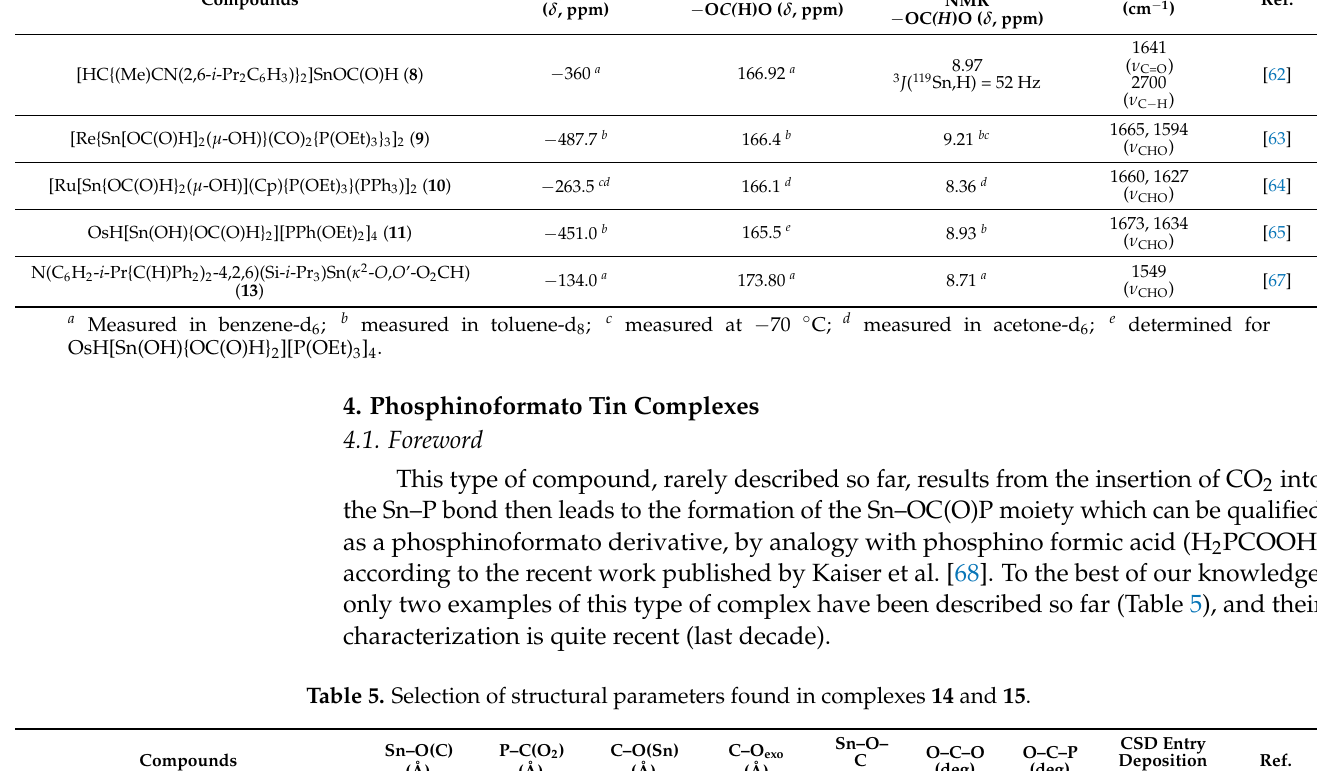
Table 4. Selection of spectroscopic data (NMR and IR) assigned to formates of tin complexes. Compounds